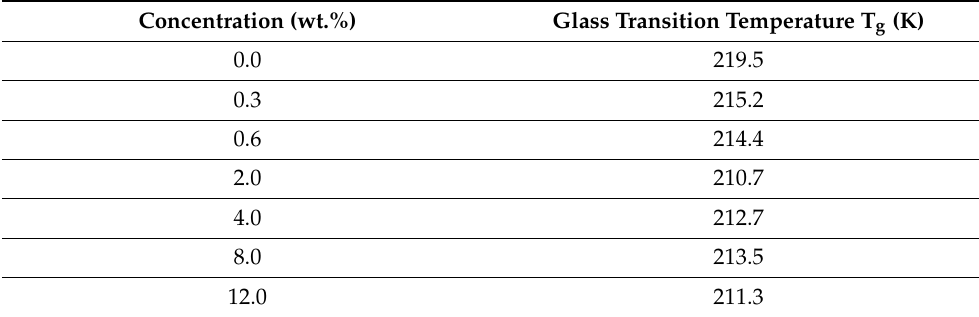
Table 4. T g values obtained at the midpoint of the DSC thermogram step for the (PEO) 4 CF 3 COOLi electrolyte and for the combinations with MWCNT.